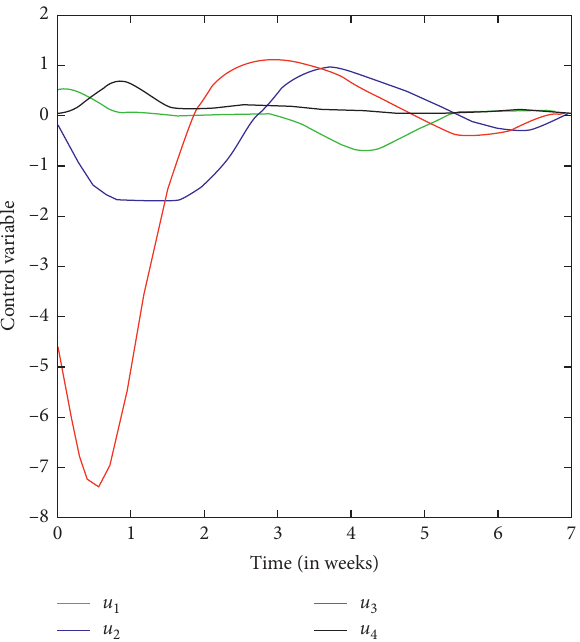
Figure 5: Variation in control variable with time.